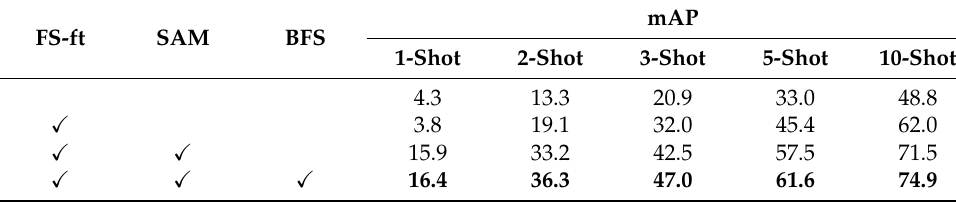
Figure 15. Results of our 20-shot model on novel classes in the DIOR dataset. Table 3. Ablation study on the NWPU VHR-10 dataset.